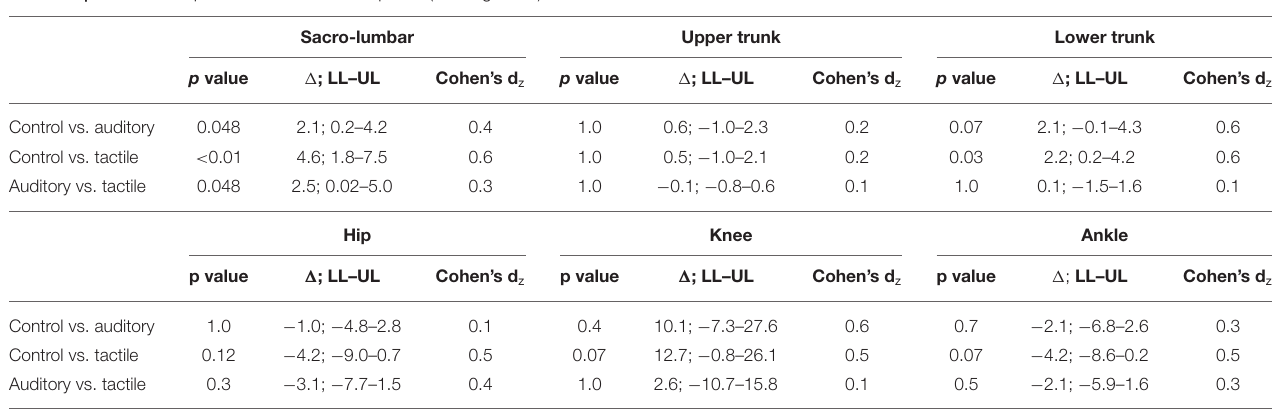
TABLE 3 | Pairwise comparisons in the retention phase (learning effect).